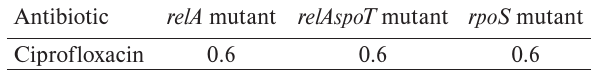
Table 2. Antibiotic resistance profile of P. aeruginosa PAO1 relA , relAspoT and rpoS mutants. MIC (μg/mL) for each antibiotic is shown.